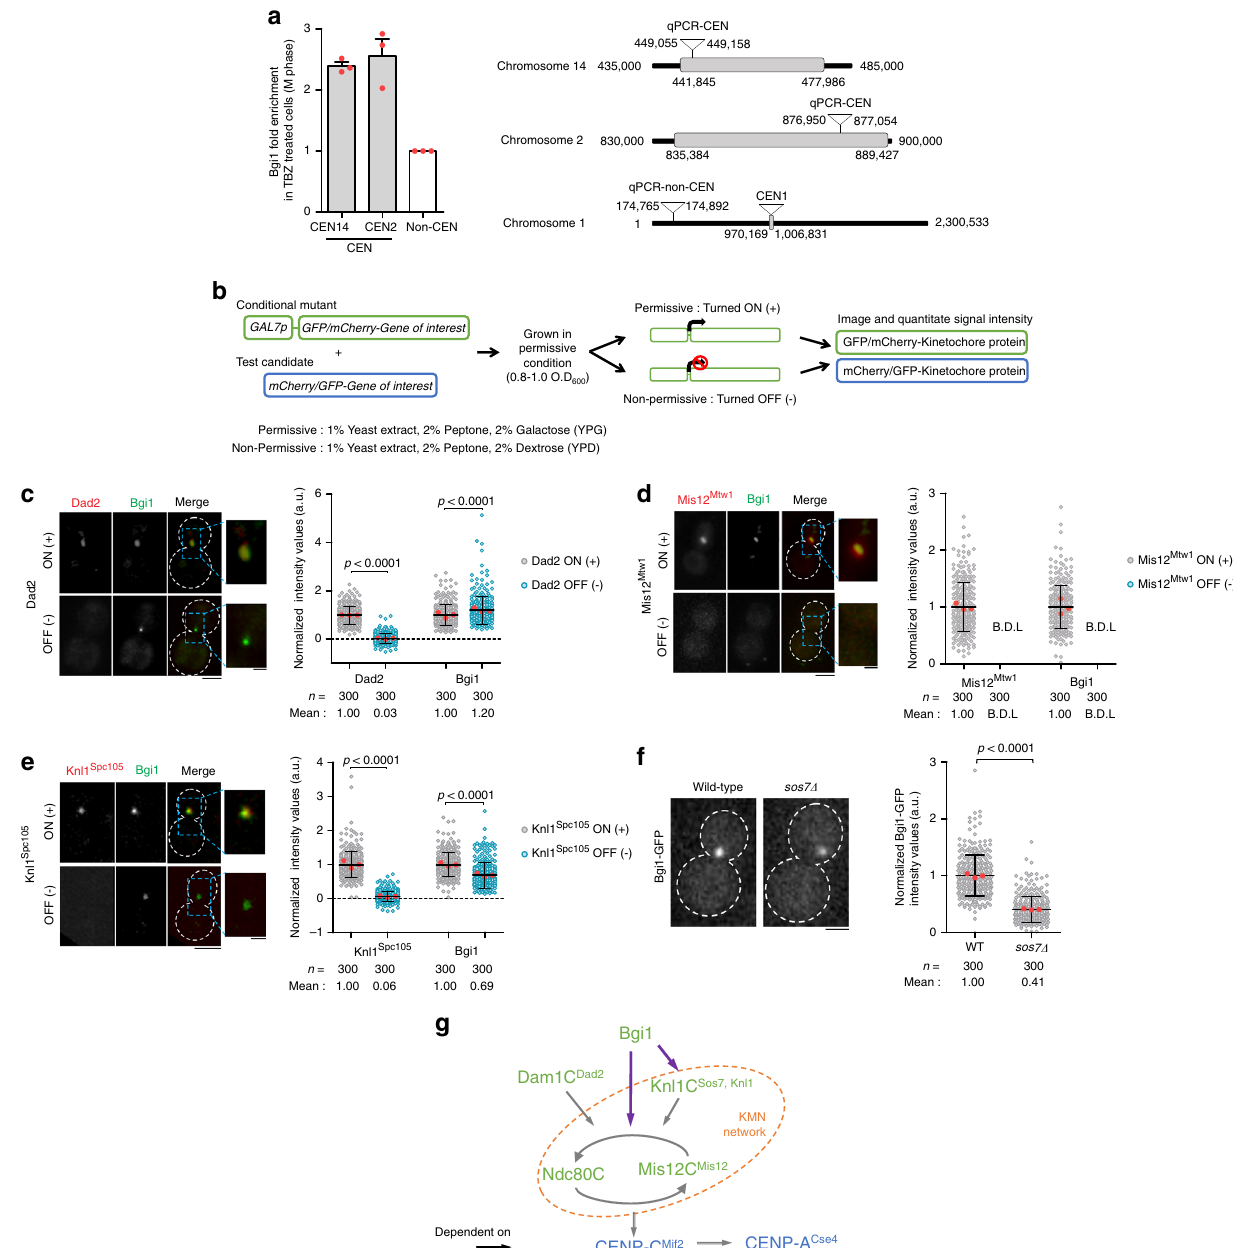
Fig. 2 Bridgin assembles onto the KMN network platform. a Left , enrichment of Bgi1 at M-phase kinetochores in SHR870 ( BGI1::BGI1-V5-GFP ) cells by cross-linked chromatin immunoprecipitation (ChIP) followed by quantitative polymerase chain reaction (qPCR). The data represent the mean ± standard deviation (S.D.) of three independent experiments. Right , schematic representing the location of qPCR primers used. Centromeric sequences are de fi ned by grey boxes. b Steps followed to determine localization interdependency at the kinetochore among its subcomplexes. c – e Left , a representative image of Bgi1-V5-GFP in c SHR906 ( DAD2::GAL7p-mCherry-DAD2 ), d SHR907 ( MIS12 MTW1 ::GAL7p-mCherry-MIS12 MTW1 ) and e SHR945 ( KNL1 SPC105 ::GAL7p-mCherry- KNL1 SPC105 ) in permissive ( + ) or nonpermissive ( − ) conditions of the GAL7p . Scale bar, 3 μ m; 1 μ m for magni fi ed inset. Right , Bgi1-V5-GFP signals and c mCherry-Dad2, d mCherry-Mis12 Mtw1 , or e mCherry-Knl1 Spc105 in cells with or without Dad2, Mis12 Mtw1 , or Knl1 Spc105 expression, respectively, were quanti fi ed and normalized to their respective mean signals in the permissive condition of the GAL7p . Signals were measured after 18, 12, and 18 h in nonpermissive conditions for Dad2, Mis12 Mtw1 , and Knl1 Spc105 , respectively. For d , the strong in fl uence of Mis12 Mtw1 on kinetochore localization of bridgin resulted in signals that were below detectable levels (B.D.L.). For e , bridgin signals in 24 out of 300 cells were below detectable levels. f Left , representative images of Bgi1-V5-GFP in wild-type H99 ( SOS7 ) or in sos7 null mutant SHR908 ( SOS7::sos7 Δ ) cells. Scale bar, 2 μ m. Right , Bgi1-V5-GFP signal intensities were quanti fi ed and normalized to the mean wild-type signal. c – f The results of three independent experiments with 100 cells each are represented. The red dot represents the mean of one experiment; mean ± S.D. is shown. For statistical comparison of differences between the samples, Mann – Whitney two- tailed analysis was applied, p values show signi fi cant differences. g Schematic describes the observed localization interdependency of inner (blue) and outer (green) kinetochore protein complexes at the C. neoformans kinetochore. Purple arrows highlight the dependency of bridgin on the KMN network. Source data are available as a Source Data fi